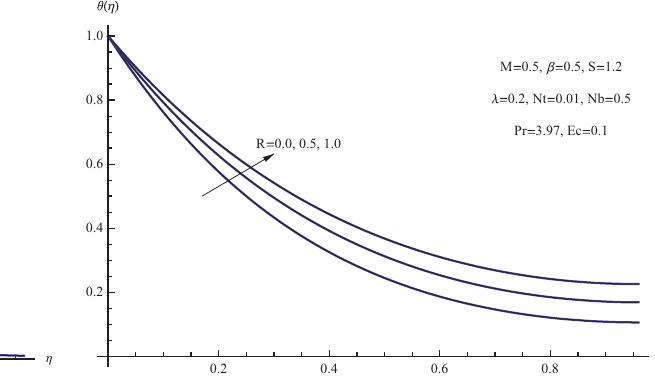
Figure 14: ( ) θ η for assorted quantities of R .